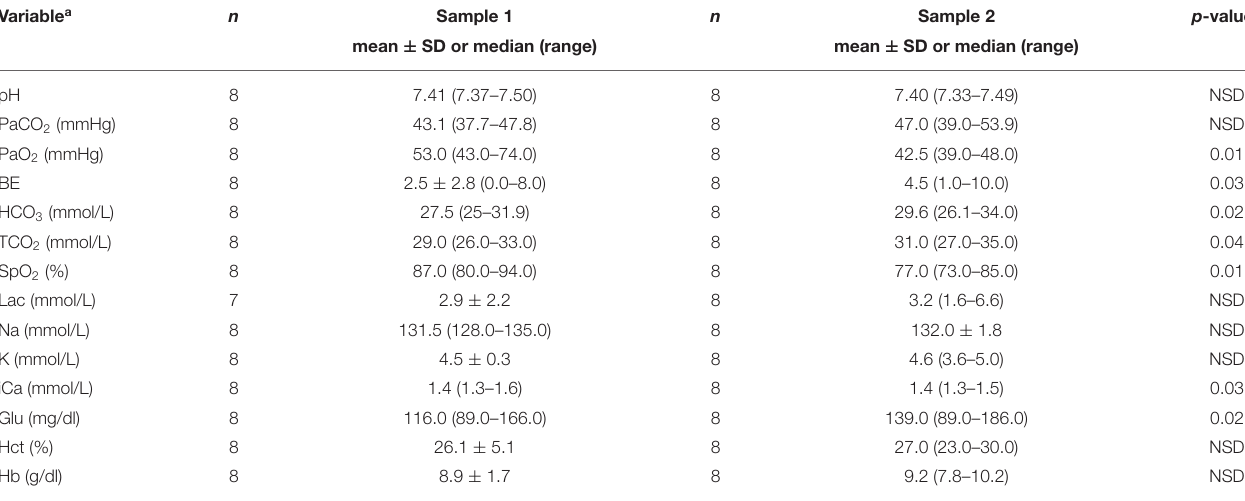
TABLE 2 | Blood gases, acid base and hematologic parameters of eight feral horses, measured 15- and 30-min post-induction. Variable